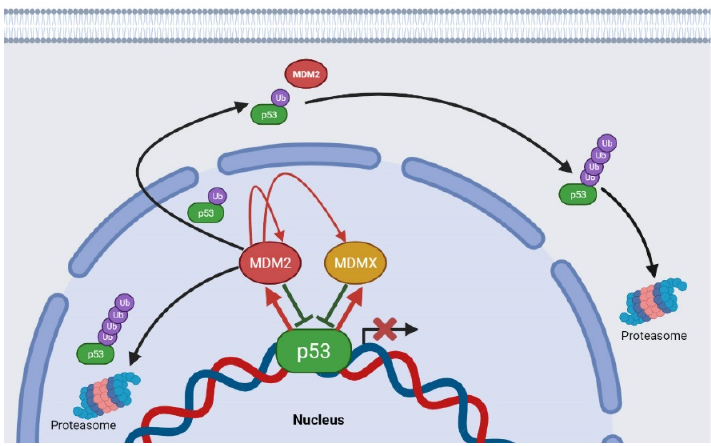
Figure 2. Effects of MDM2 and MDMX in p53. p53 regulates MDM2 and MDMX transcription levels (red arrows), while MDM2 and MDMX inhibit p53 transcriptional function. MDM2 can also promote p53 nuclear export to the cytoplasm and its ubiquitin-mediated degradation by the proteasomes. MDM2 can also promote the nuclear degradation of p53 (polyubiquitination), MDMX ubiquitination, and its own ubiquitination and degradation. Ub: ubiquitin.